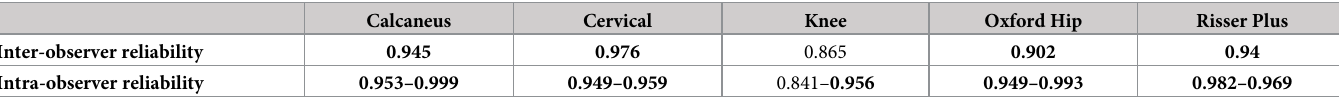
difficulty with the scan itself. Foot positioning also caused difficulty, with overlap of the feet being the cause of 22.7% of those with moderate difficulty. That being said, this method was found to be the fastest (17.7s) and raters reported high levels of satisfaction, as it was easy to learn, use and remember. In the original description inclusion of plantar sesamoid evaluation is recommended, but due to the absence of the dorso-plantar plane and significant overlap between feet on the lateral image it was not felt to be reliable and it was not included in our assessment. The calcaneus method is based on the historical Greulich-Pyle ‘Brush’ population Table 1.